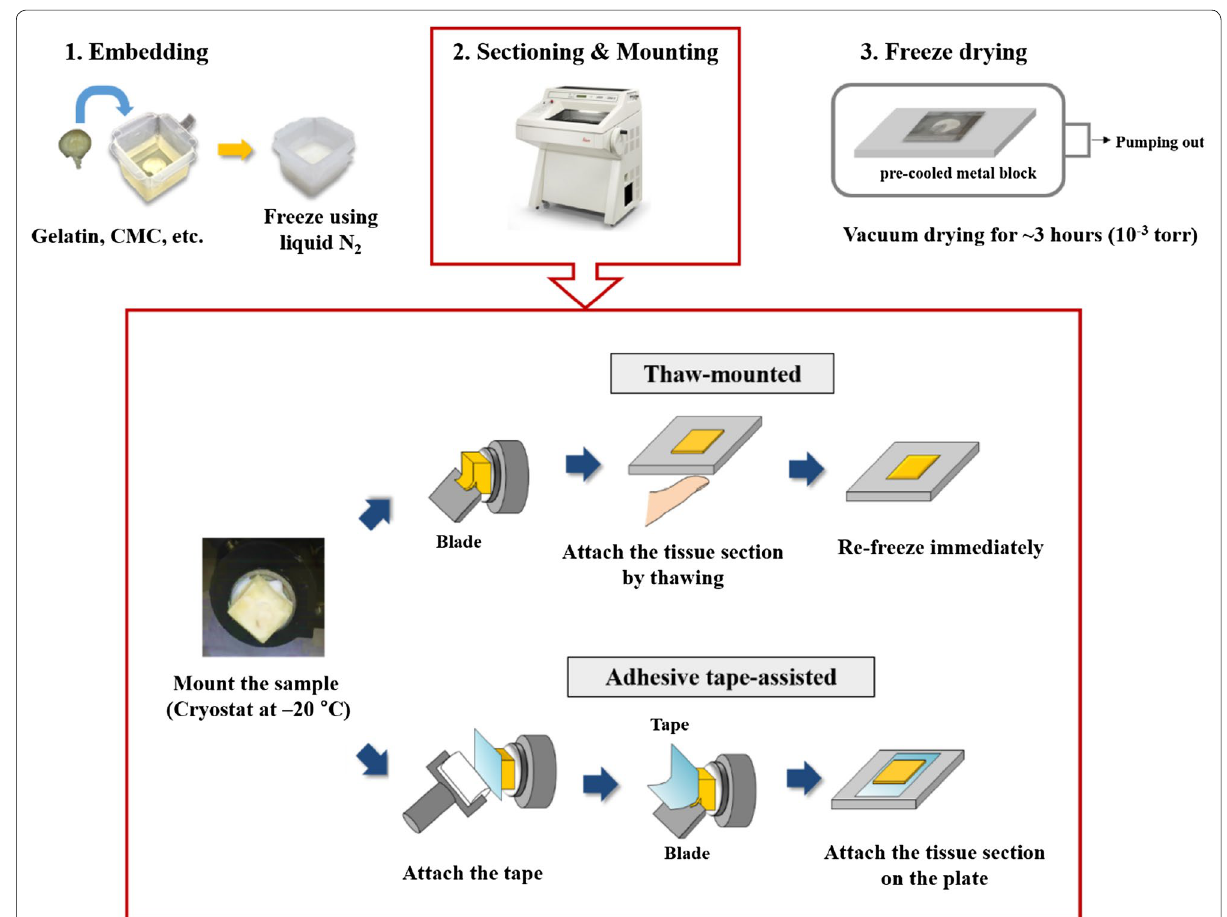
Fig. 1 Typical work flow of tissue section preparation for MSI (Reproduced from ref. [85] with permission, ©